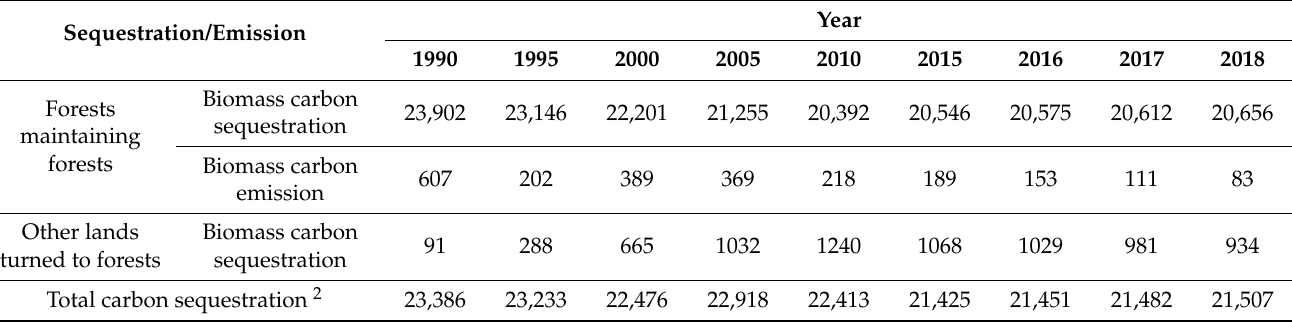
Table 3. Taiwan’s carbon sequestration by forestry sector 1 .